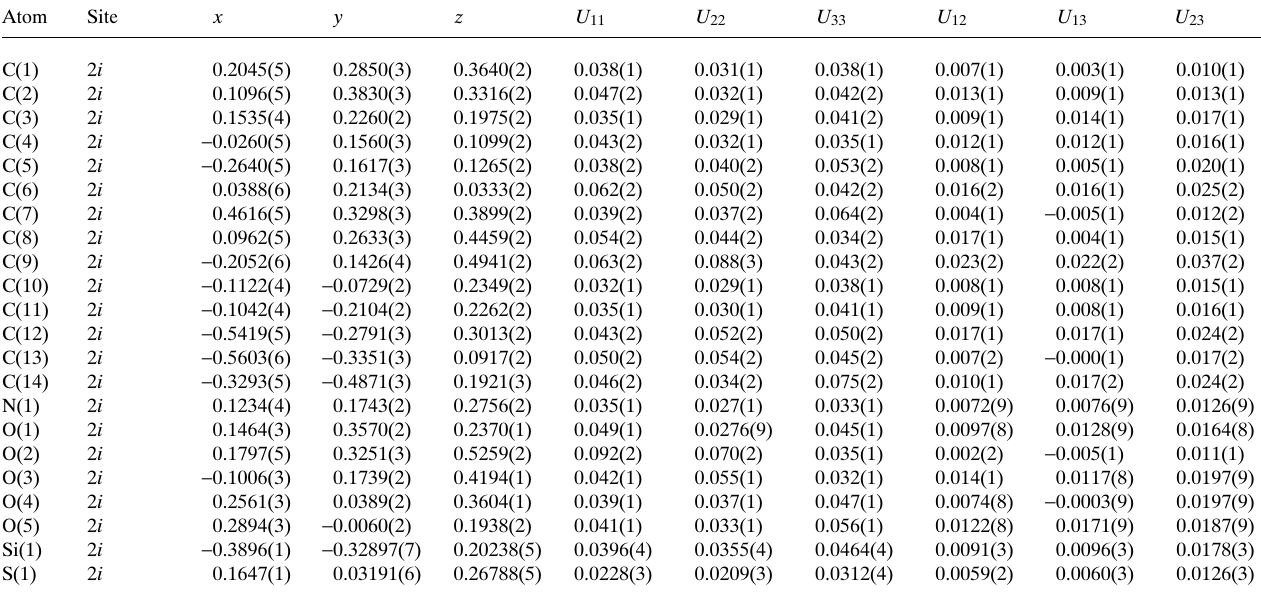
Table 3. Atomic coordinates and displacement parameters (in Å 2 )